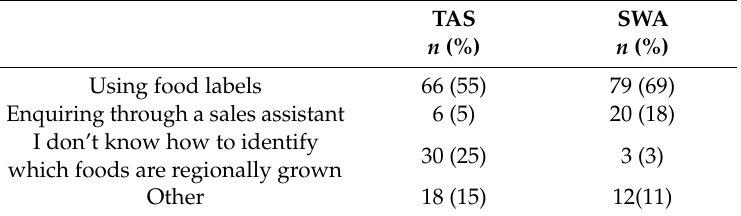
Table 2. Methods used to identify RGFFV in Tasmania and SWA.